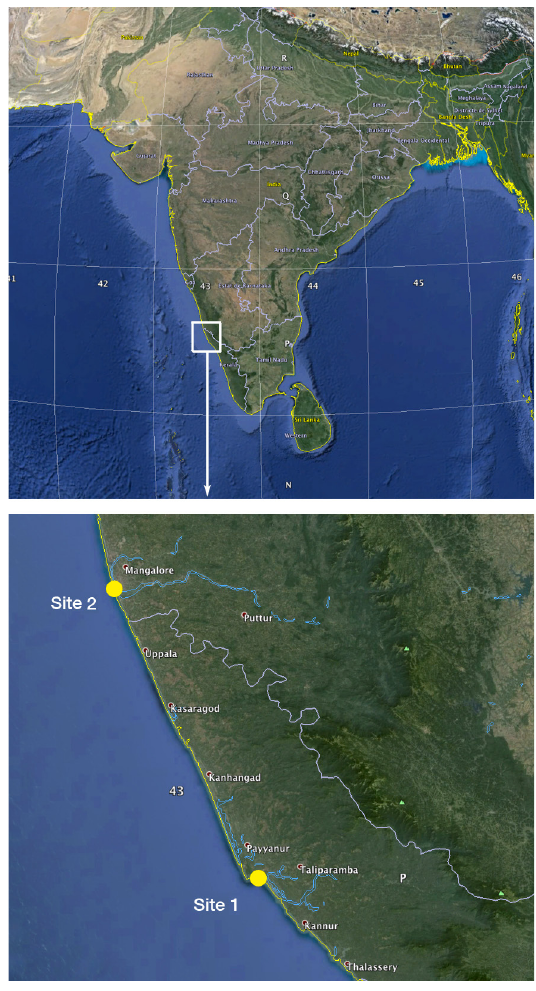
Fig. 1. – Map of study sites (Site 1, Payyannur; Site 2, Panambur) (Source: